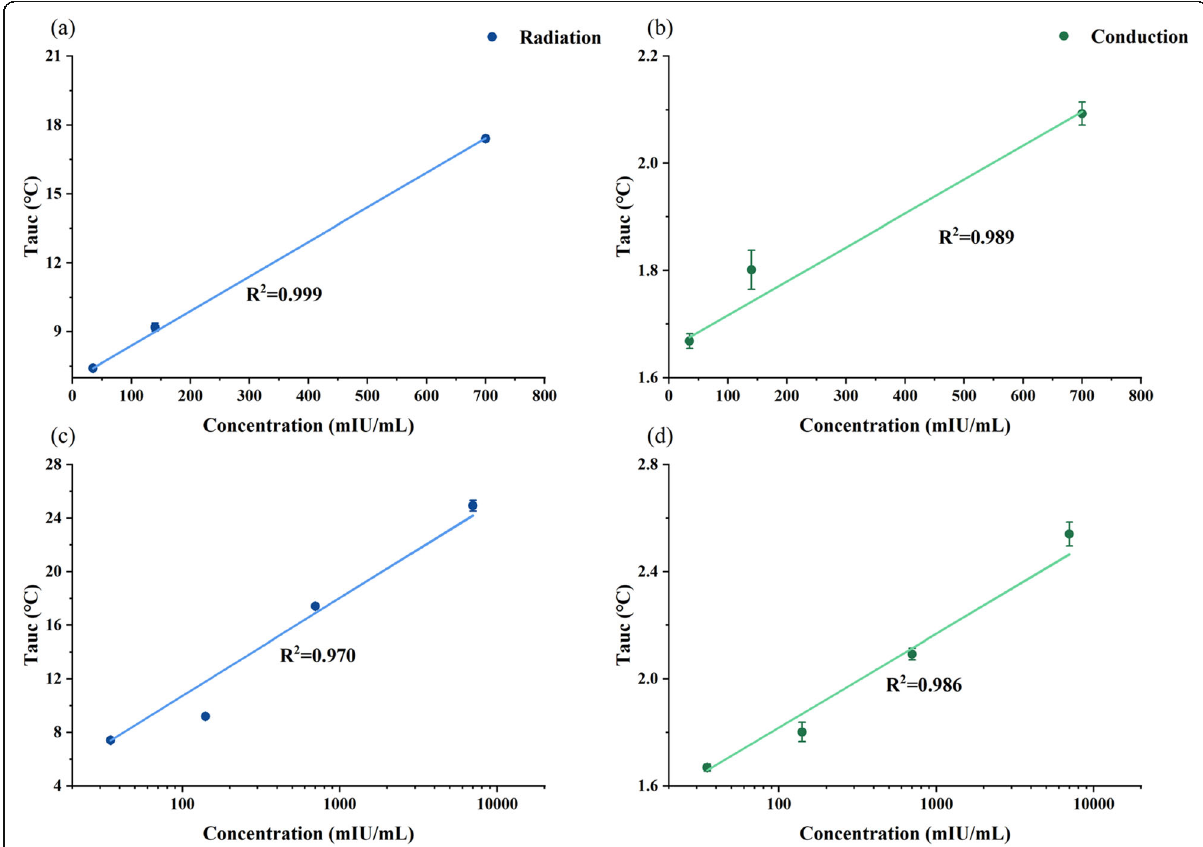
Fig. 6 The standard curves of HCG. a A linear curve between the logarithm of the HCG concentration and the thermal signal in radiation mode. b A linear curve between the logarithm of the HCG concentration and the thermal signal conduction mode. c The quantification results of HCG in radiation mode. d The quantification results of HCG in conduction